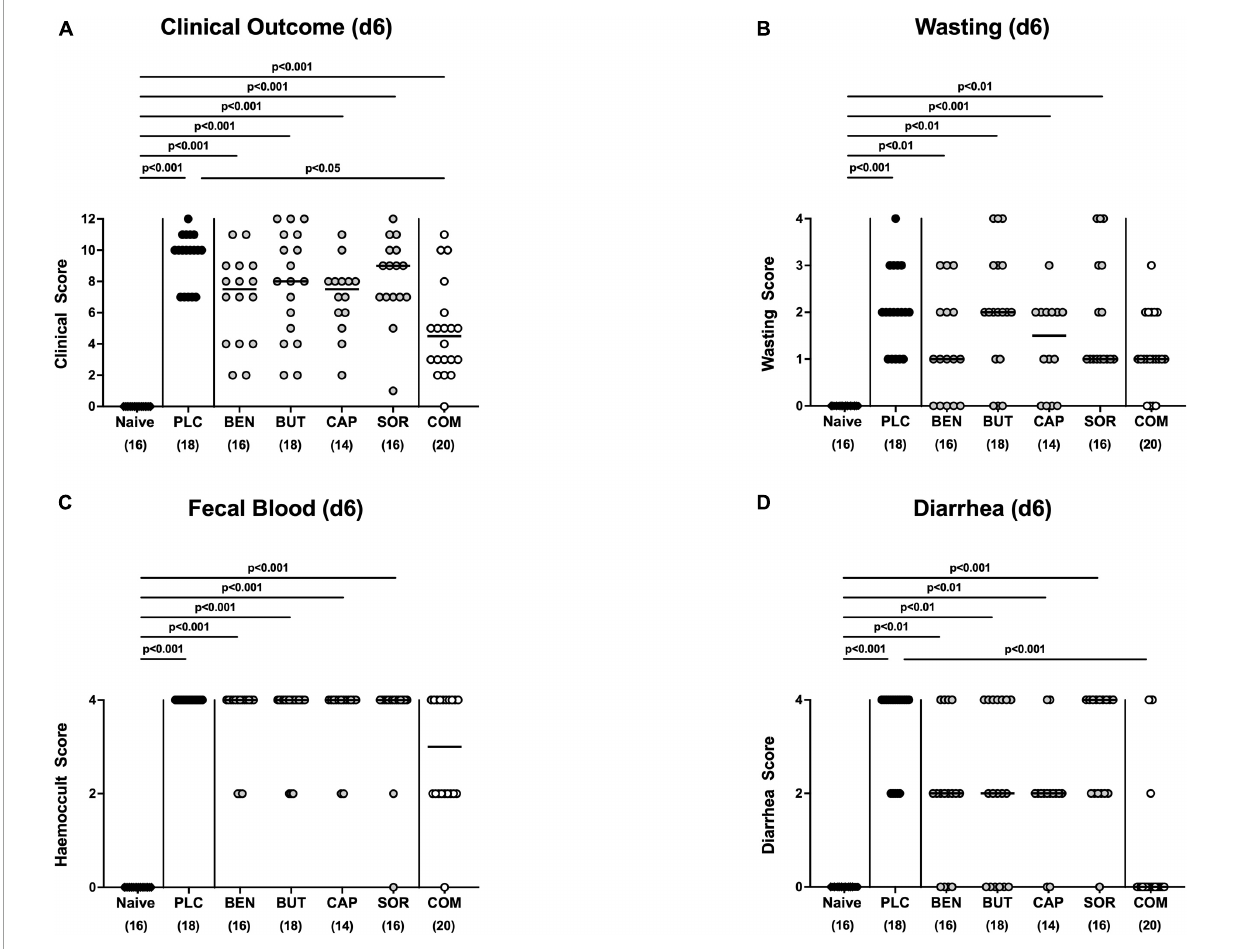
FIGURE3 Clinical outcome upon single and combined organic acid treatment on day 6 post-infection. Infected mice received a treatment with benzoic acid (BEN), butyric acid (BUT), caprylic acid (CAP), sorbic acid (SOR), or a combination of all acids (COM), whereas the placebo (PLC) group received autoclaved tap water only. On day 6 (d6) post-infection, (A) the clinical outcome was assessed in each mouse by standardized clinical scores evaluating in particular (B) wasting, (C) fecal blood, and (D) stool consistency (diarrhea). Naive mice served as untreated and uninfected controls. Medians (black bars), significance levels ( p values) calculated by the ANOVA test with Tukey’s post-correction or by the Kruskal–Wallis test and Dunn’s post-correction and the total mice numbers (in parentheses) are given. Data were pooled from three independent